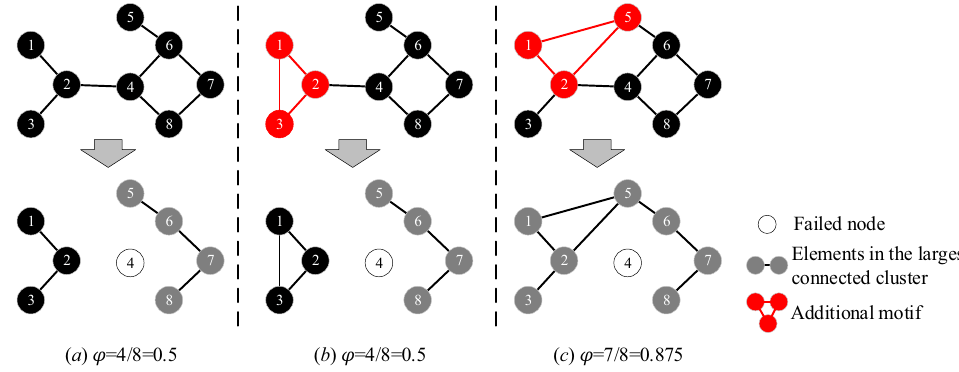
Figure 13. Robustness of the network under different formations of M 2 .